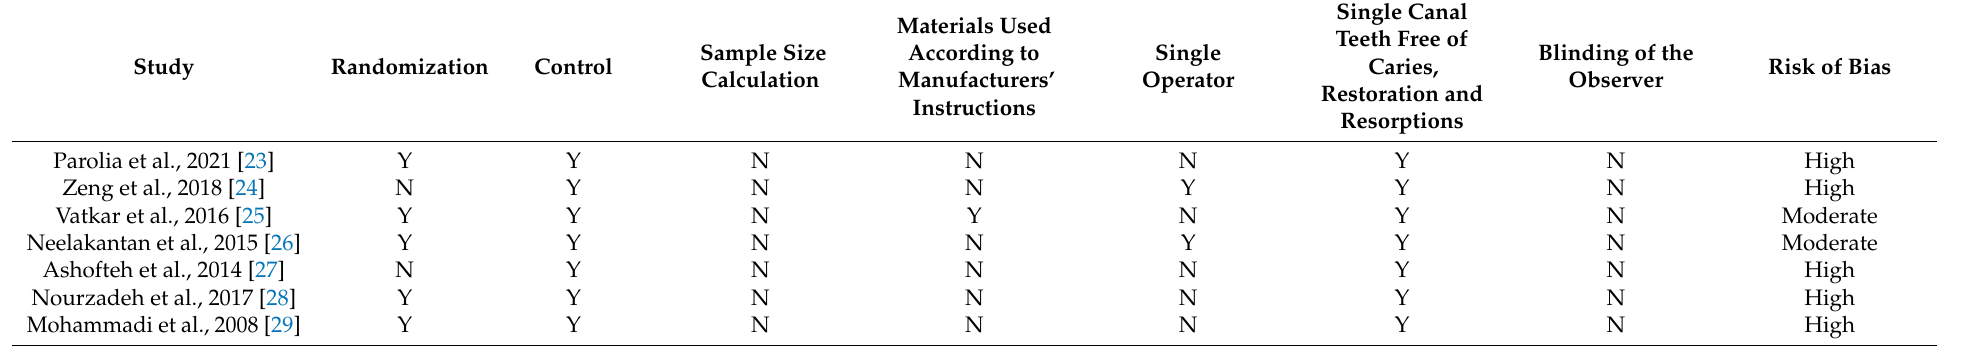
Table 2. Risk of bias of the included studies.